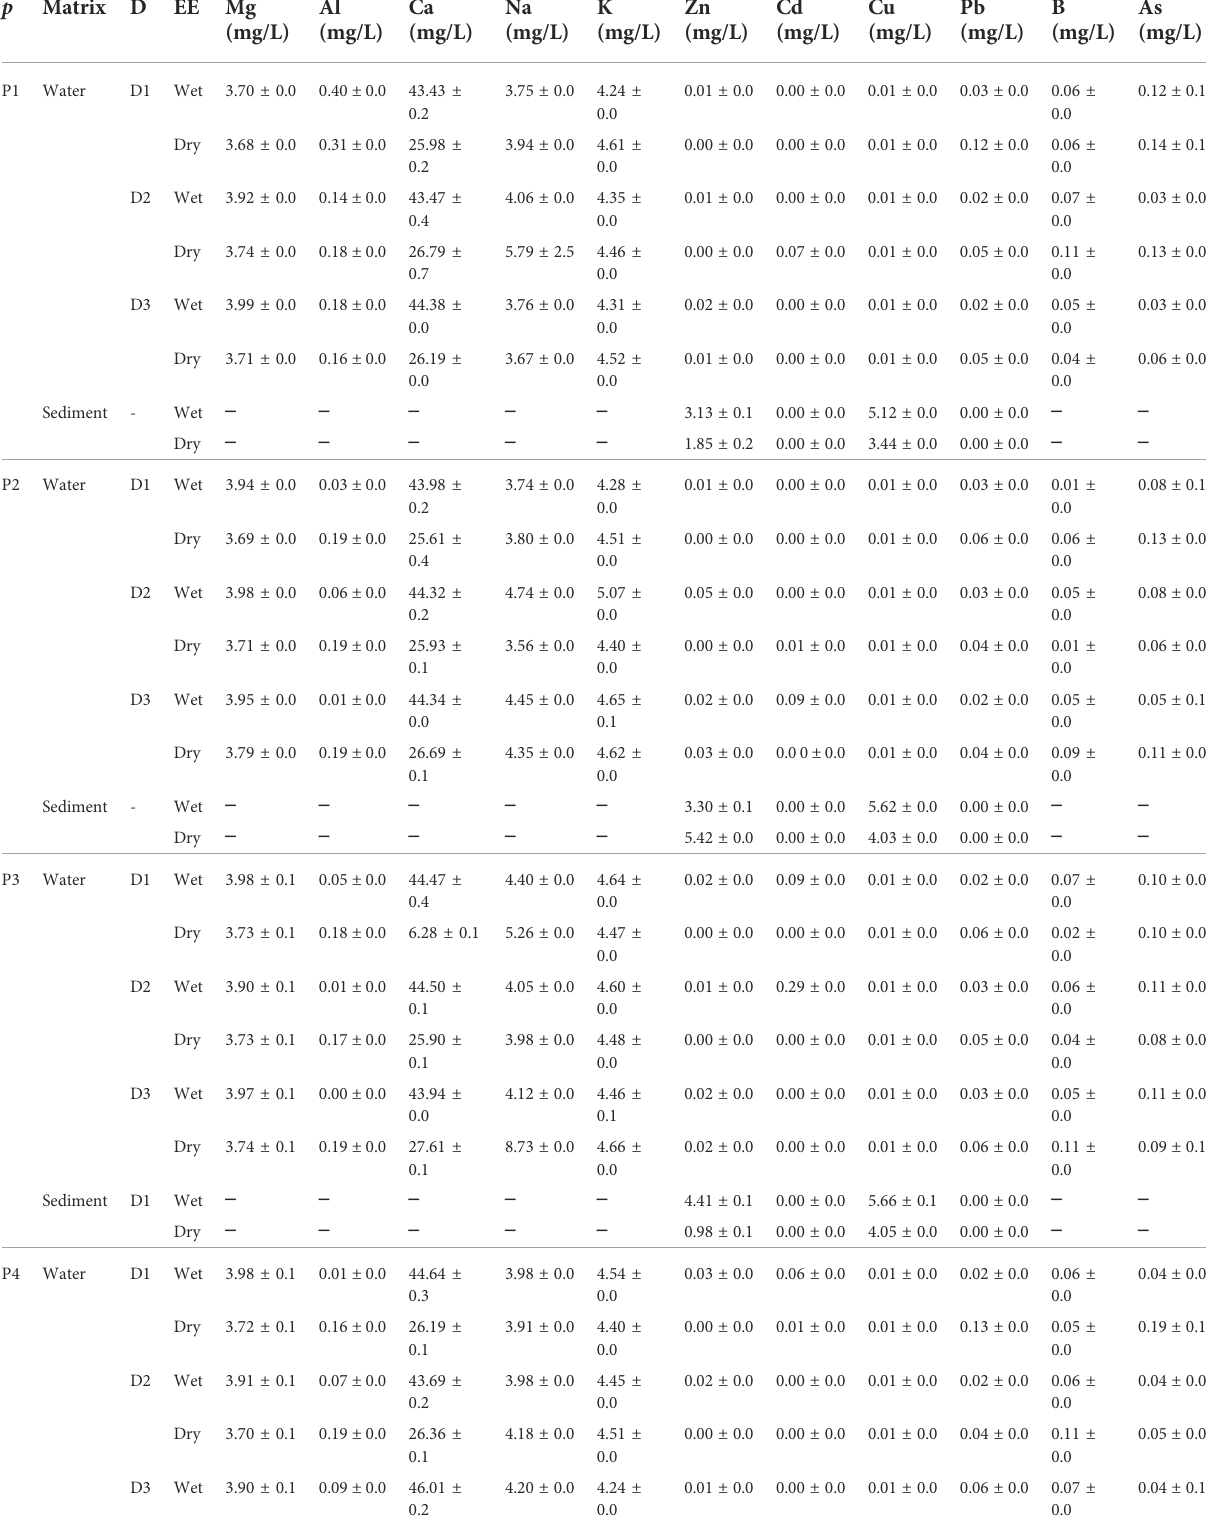
TABLE 2 Concentration of metals and metalloids in the water and